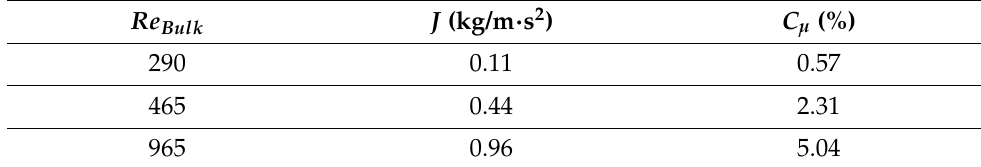
Table 1. Test conditions for jet-on